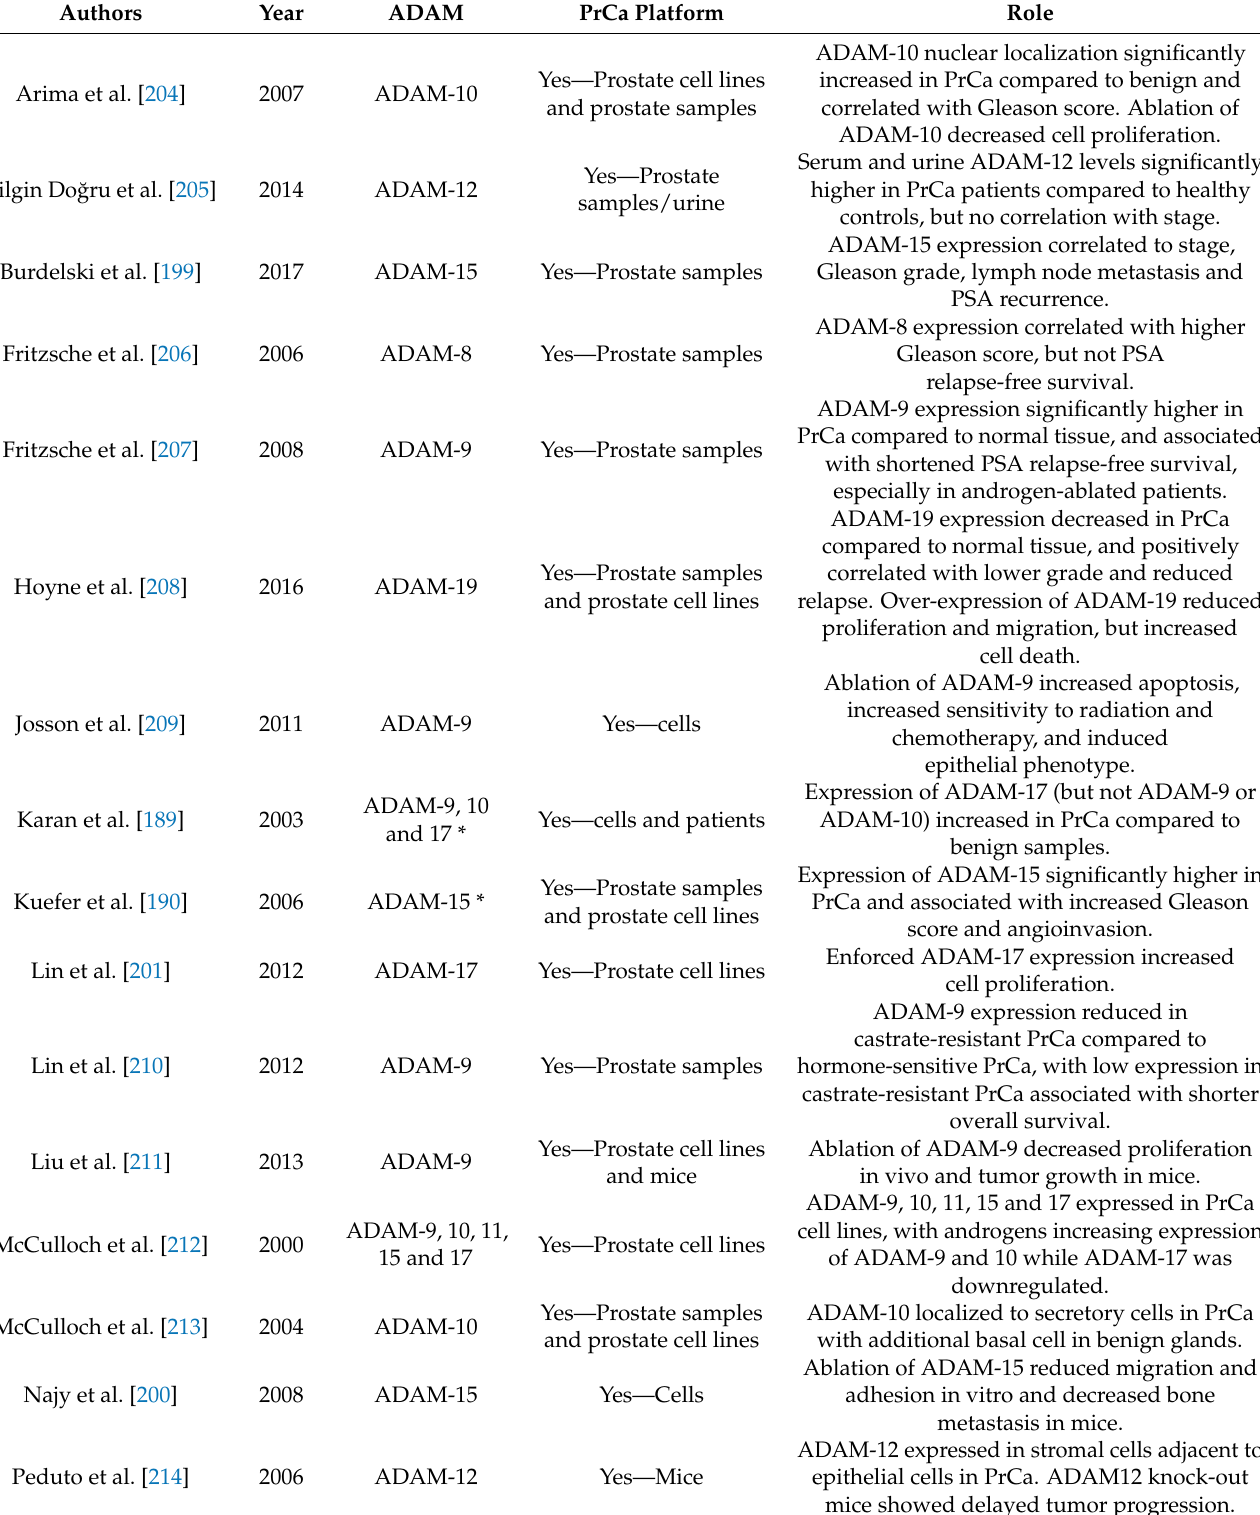
Table 4. Studies on A Disintegrin and Metalloproteinases (ADAMs) in